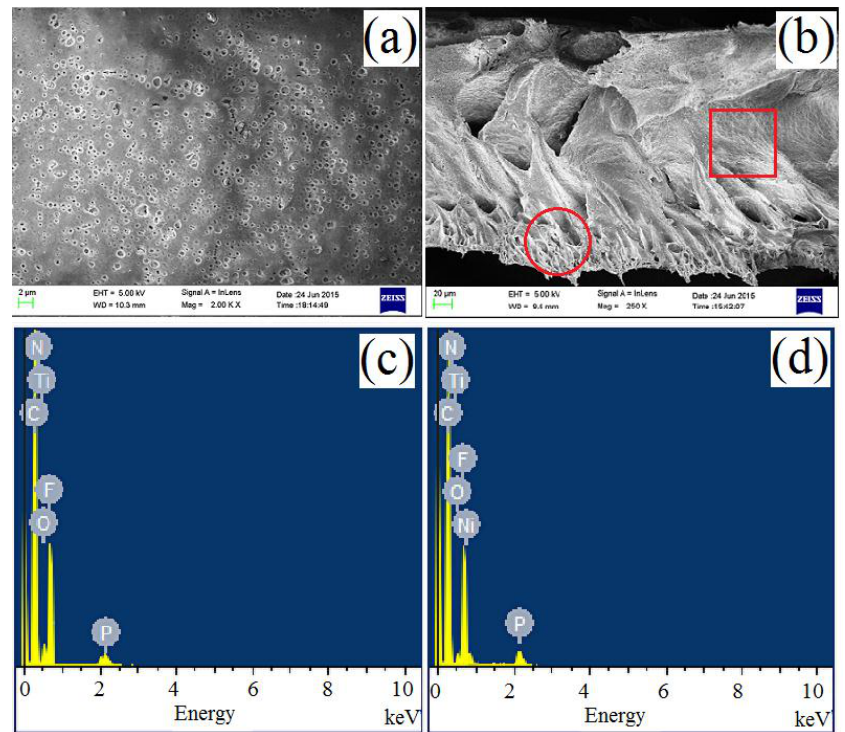
Figure 1. FE-SEM pictures and the EDS spectra of the ethylenediamine tetra(methylene phosphonic acid) (EDTMPA)-tetrabutyl orthotitanate (TBOT)/PVDF membrane: ( a ) surface morphology; ( b ) sectional morphology; ( c ) EDS before Ni(II) adsorption; ( d ) EDS after Ni(II) adsorption.